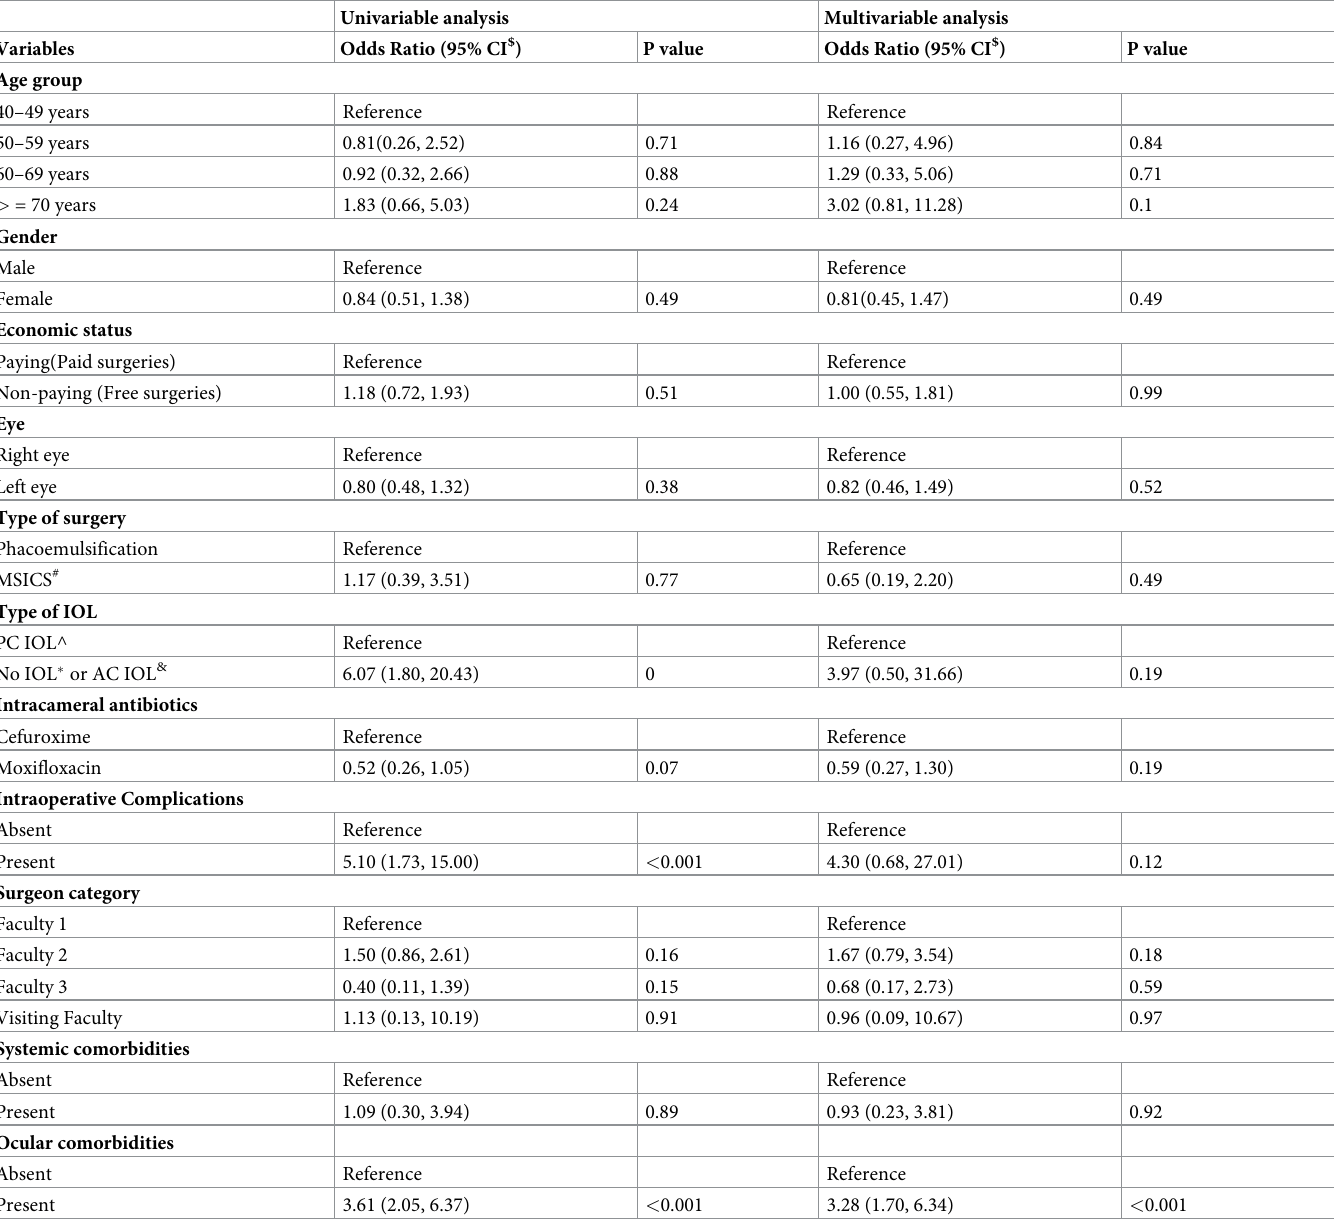
Table 5. Univariable and multivariable association of demographics, surgical factors with visual outcome of 6/12 or better at 4–11 weeks follow-up. Univariable